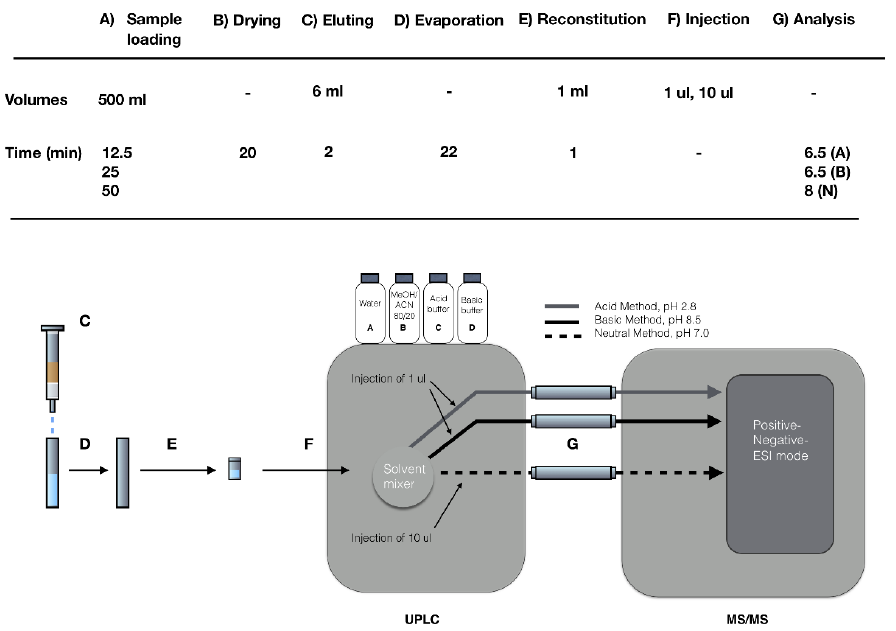
Figure 3. Schematic layout of the entire analytical procedure to put the sample preparation steps of the analytical chain in context, and to give a brief summary of the UPLC MS/MS system setup.